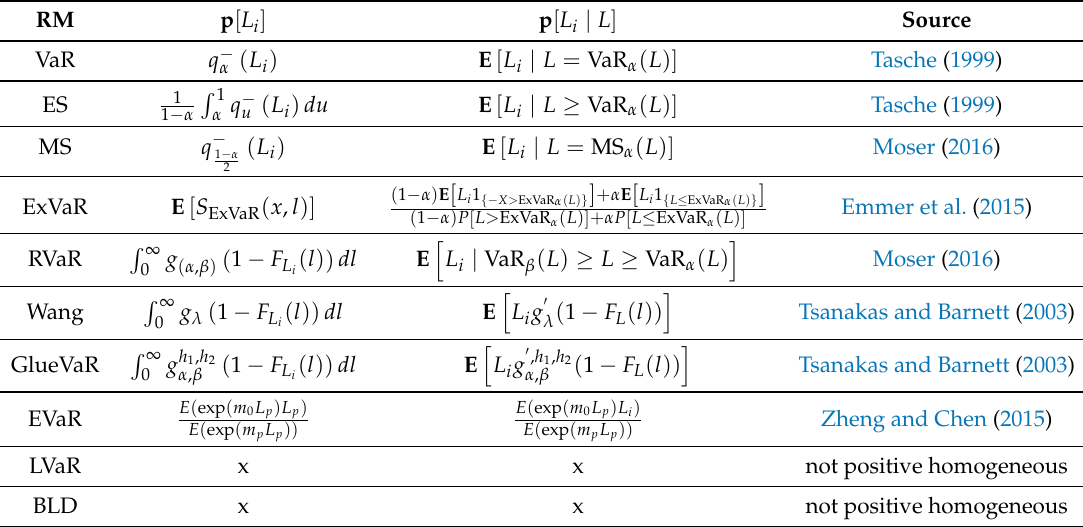
Table 2. Risk contribution and the Euler